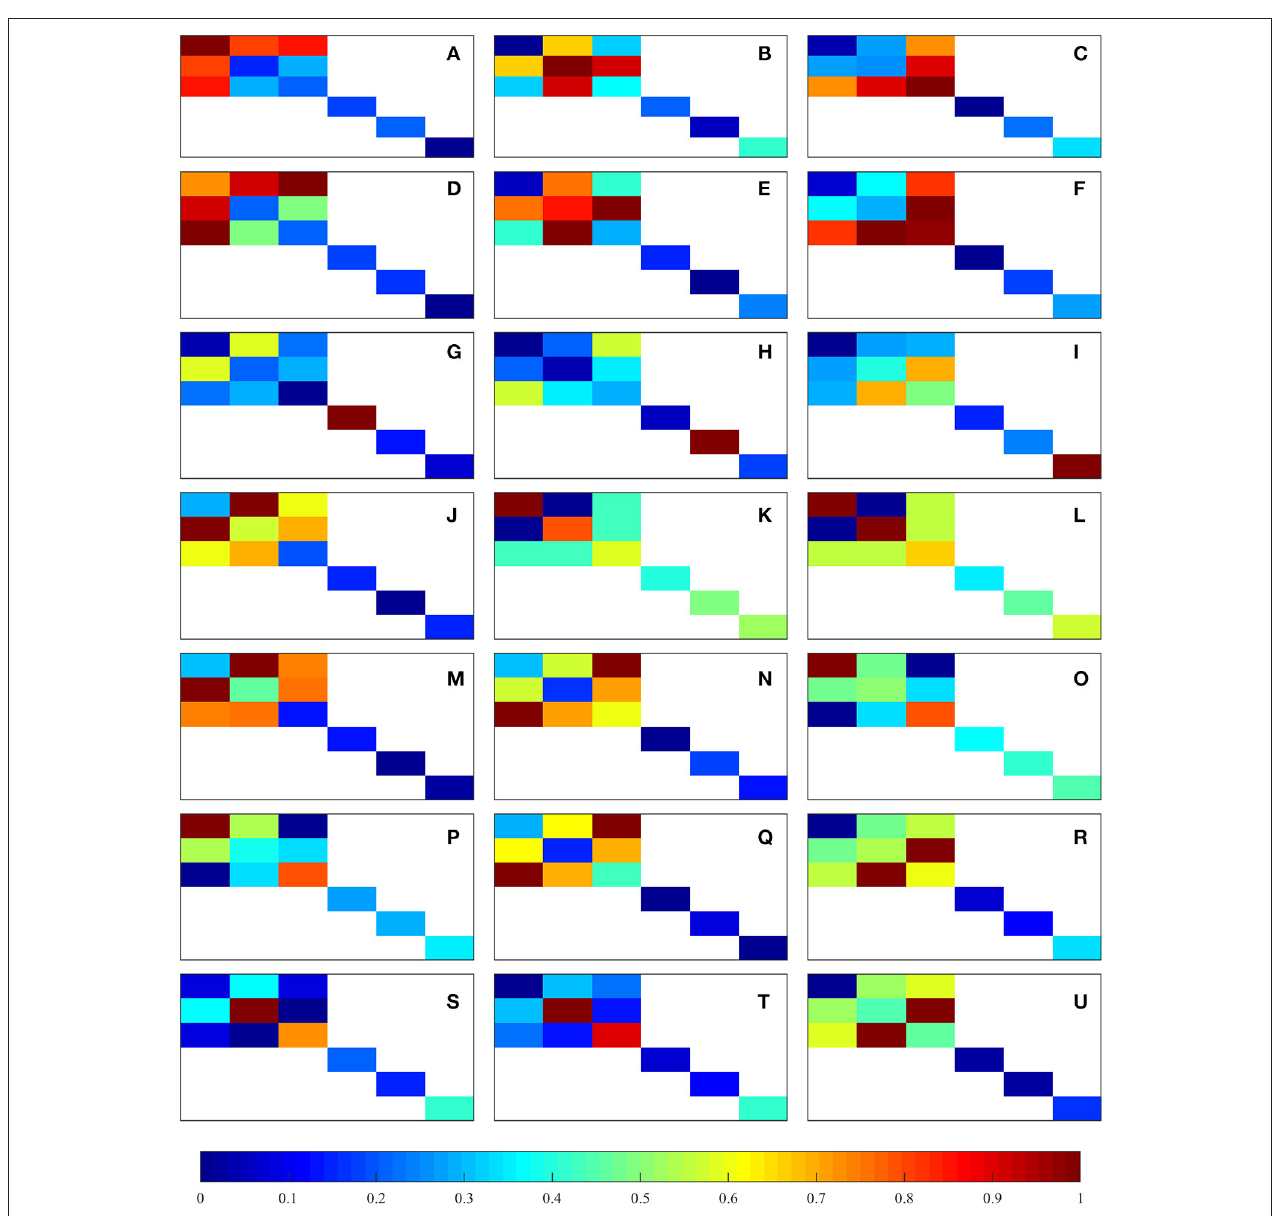
FIGURE 4 | Graphical representation of the normalized component-wise means of [ D ] ij . The represented load cases are shown in Table 1 : (A–C) correspond to uniaxial tension, (D–F) correspond to uniaxial compression, (G–I) correspond to shear, and (J–U) correspond to multi-axial in normal strain space.